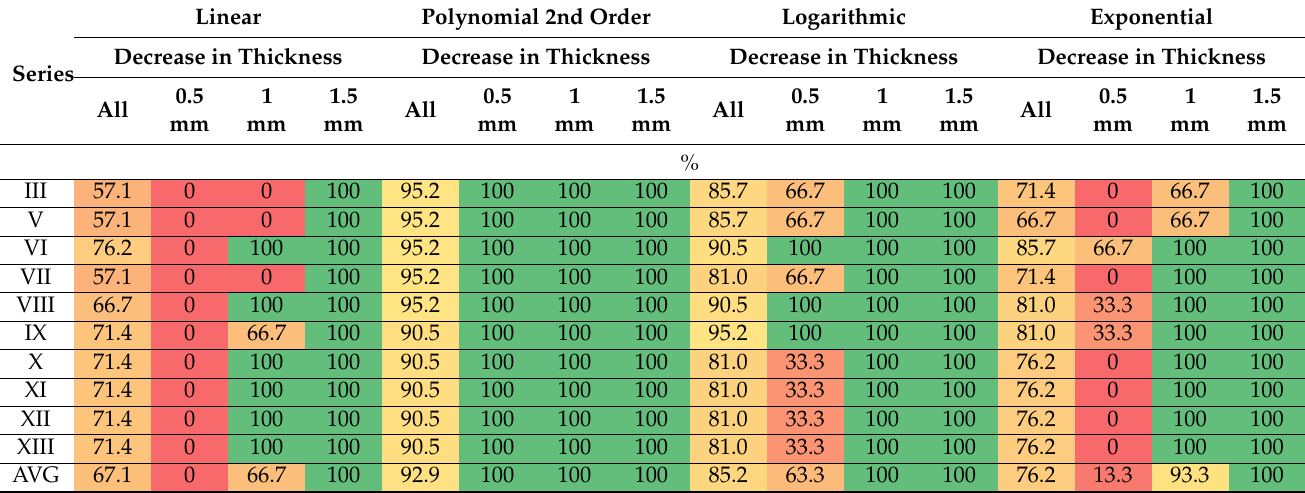
Table 2. Calculated indexes of identifying points in places with reduced wall